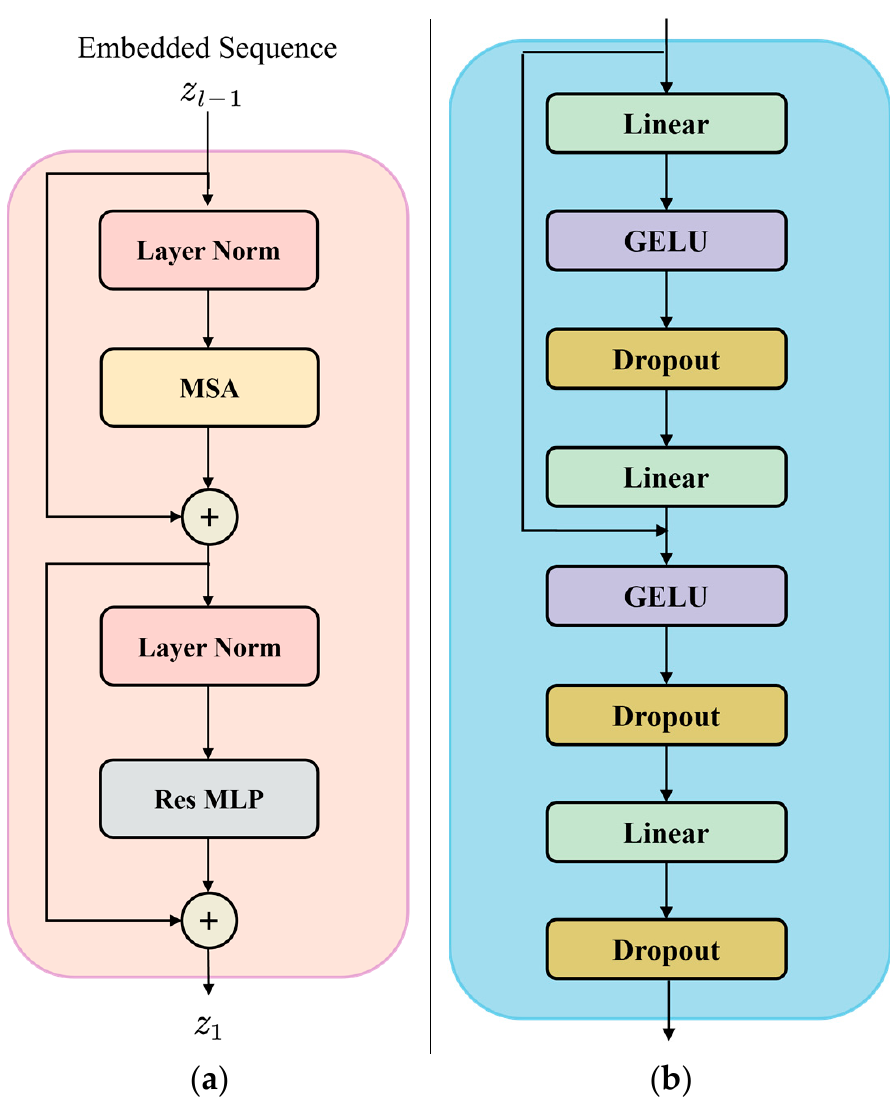
Figure 4. Improved Transformer structure diagram: ( a ) RL-Transformer structure; ( b ) ResMLP structure. The RL-Transformer encoder consists of the l -layer multi-head self-attention mecha- nism (MSA) and ResMLP as shown in Equations (4) and (5). Therefore, the output of layer l can be written as: